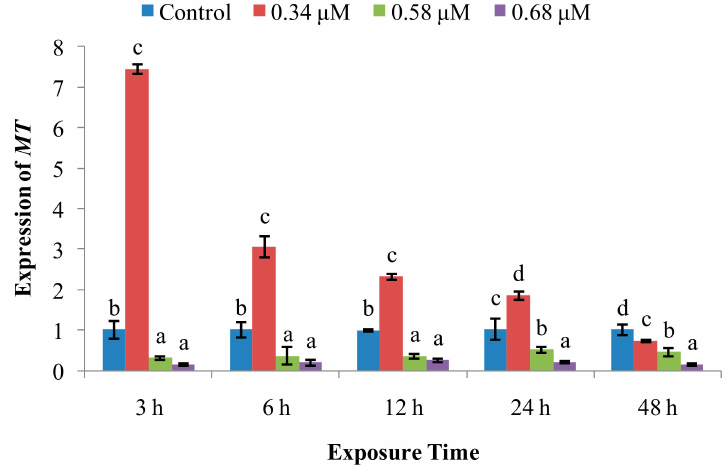
Figure 9. E ff ect of TD 49 on hemolymph expression of MT at di ff erent time points after exposure to di ff erent concentrations (0, 0.34, 0.58, 0.68 µ M) of TD 49 . Data represent mean ± SD values ( n = 3) at the same time interval, with di ff erent letters denoting significant di ff erences ( p <